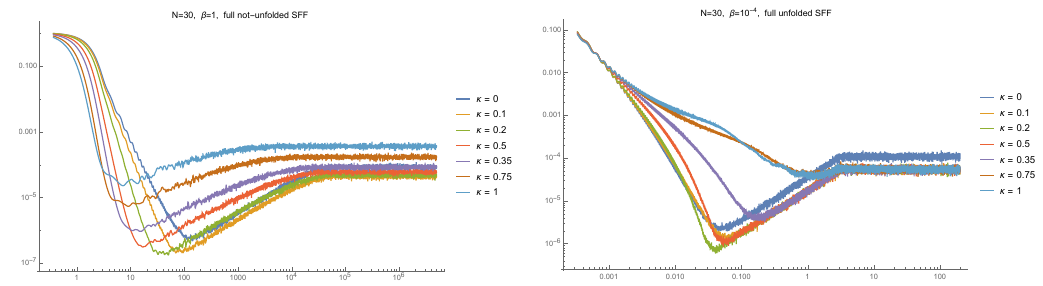
Figure 1 . Left: the full, not-unfolded, SFF for the case of N = 30 and for increasing values of (cid:20) . Right: the full, unfolded, SFF for the case of N = 30 and for the same values of (cid:20) . In both cases, the average is performed over M = 100